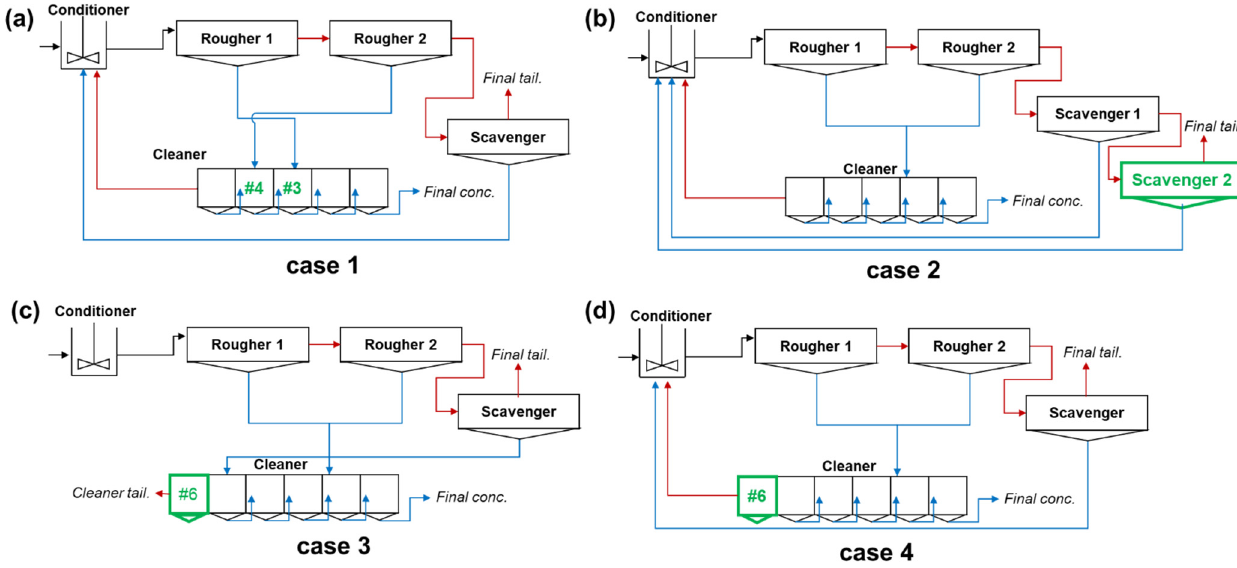
Figure 2. Flow diagram of flotation circuit of alternative circuits. ( a ) Case 1: transfer float from rougher 1 bank to cleaner 3, transfer float from rougher 2 bank to cleaner 4; ( b ) Case 2: scavenger bank is added; ( c ) Case 3: open circuit with addition of cleaner bank; ( d ) Case 4: closed circuit with addition of cleaner bank. Blue line represents stream of floated products, and red line represents stream of sinked products after flotation. Green text represents changes in the existing process. 2.6. LCA LCA, which is based on partition-based separation, is effective for analyzing the con- nection and configuration of each unit [26,33,34]. In addition, because the circuit configu- ration allows the separation efficiency (SE) to be determined, the performance of circuits with different configurations can be evaluated easily [26]. The evaluation was performed by calculating the overall circuit concentrate-to-feed ratio (C/F) using the partition proba- bility (P) of each unit process. The recovery of a unit is expressed as the probability of the unit process as a function of the experimental variable (Z). The recovery of the entire cir- cuit can be expressed in the form of an algebraic expression using this P [26,33,34]. For example, as shown in Figure 3, if the recoveries of each process are P 1 and P 2 , then the recovery (C/F) of the entire process becomes P 1 × P 2 . In this process, if the recovery as a function of the experimental variable of the unit process is known, then a partition curve of the overall recovery with respect to the experimental variable can be constructed. As- suming that P is the same for each process, the SE of the entire process can be compared with the efficiency of the unit process based on the slope value (d(C/F)/dP, P = 0.5) at the point where P is 50% [26,35]. As shown in Figure 3, C/F is P 2 when P 1 = P 2 = P; therefore, when P = 0.5, the slope value is 1, which is the same as the efficiency of the unit process. In the case of a complex process such as a multistage flotation circuit, it is difficult to cal- culate the algebraic expression directly. Therefore, the recovery and SE of the entire circuit were calculated using the matrix reduction algorithm proposed by Noble and Luttrell [26]. Figure 3. Example of linear circuit analysis. F is the feed rate, T 1 the sunk product rate, P 1 and P 2 the recovery for each unit bank, and C the concentrate rate.